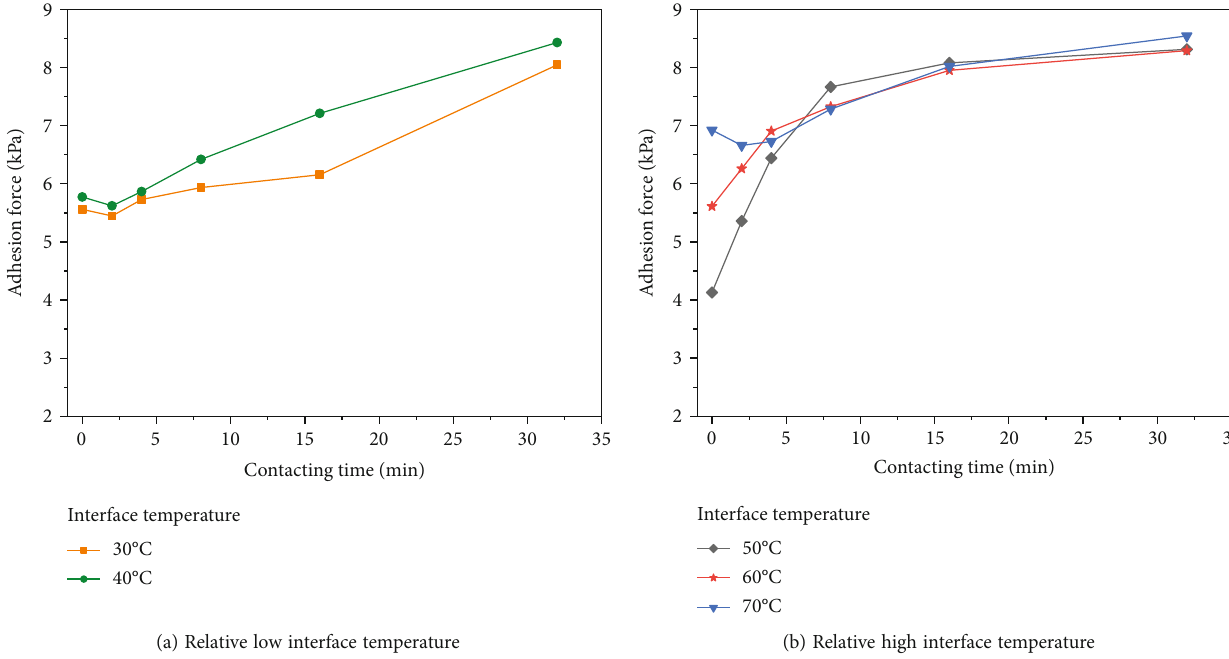
Figure 9: Adhesion force changes with contacting